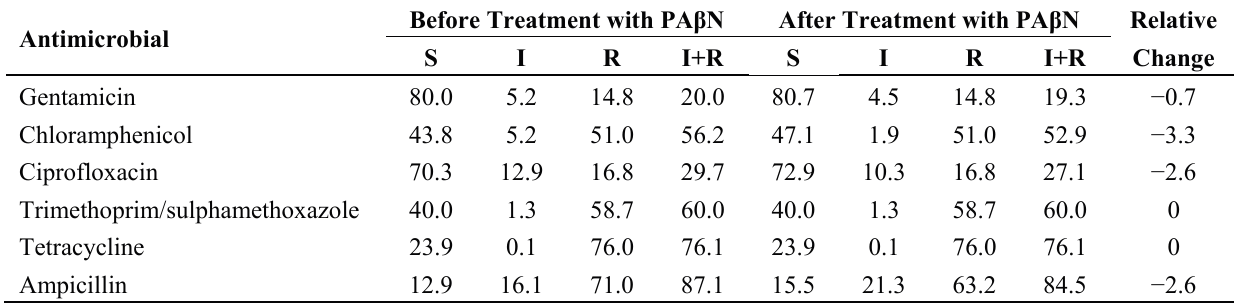
Table 3. Prevalence (%) of antimicrobial resistance among 155 representative E. coli isolates from animals before and after treatment with efflux pump inhibitor (PA β